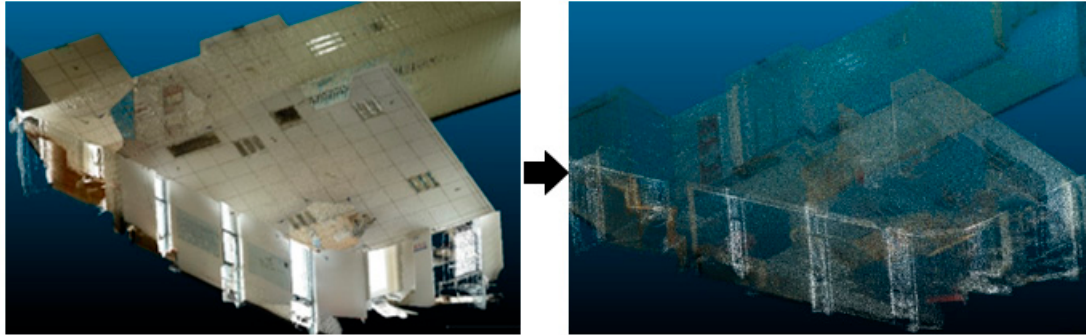
Figure 4. LiDAR point cloud data voxel grid downsampling.